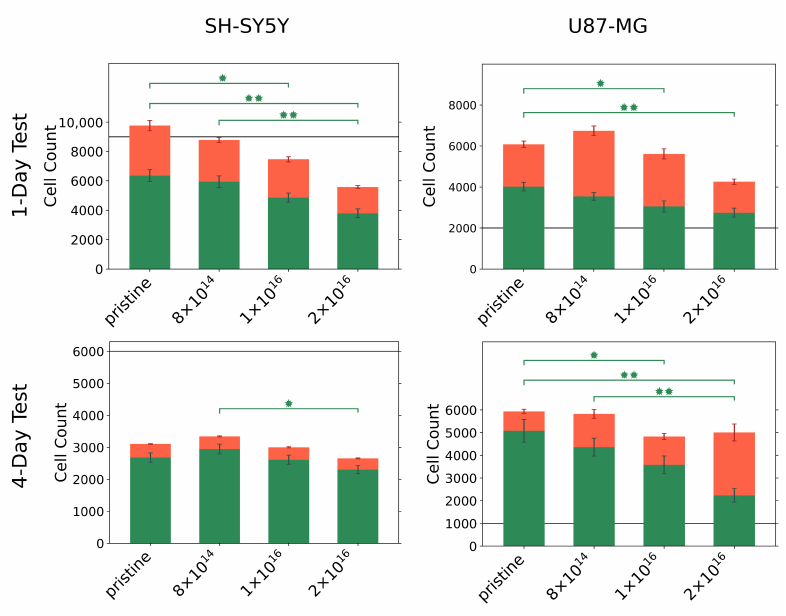
Figure 3. Number of viable (green) and dead (red) U87-MG and differentiated SH-SY5Y cells on pristine and Cimplanted TNSs after 1 and 4 day(s). Initially, 2000 U87-MG cells per square centimeter and 9000 differentiated SH-SY5Y cells per square centimeter were seeded for the one-day test (gray line). To perform the four-day test, 1000 U87-MG cells per square centimeter and 6000 differentiated SH-SY5Y cells per square centimeter were seeded (gray line). Significant differences of p < 0.05 are marked with (*), and differences of p < 0.01 are marked with (**). Ion fluences are given in ions · cm − 2